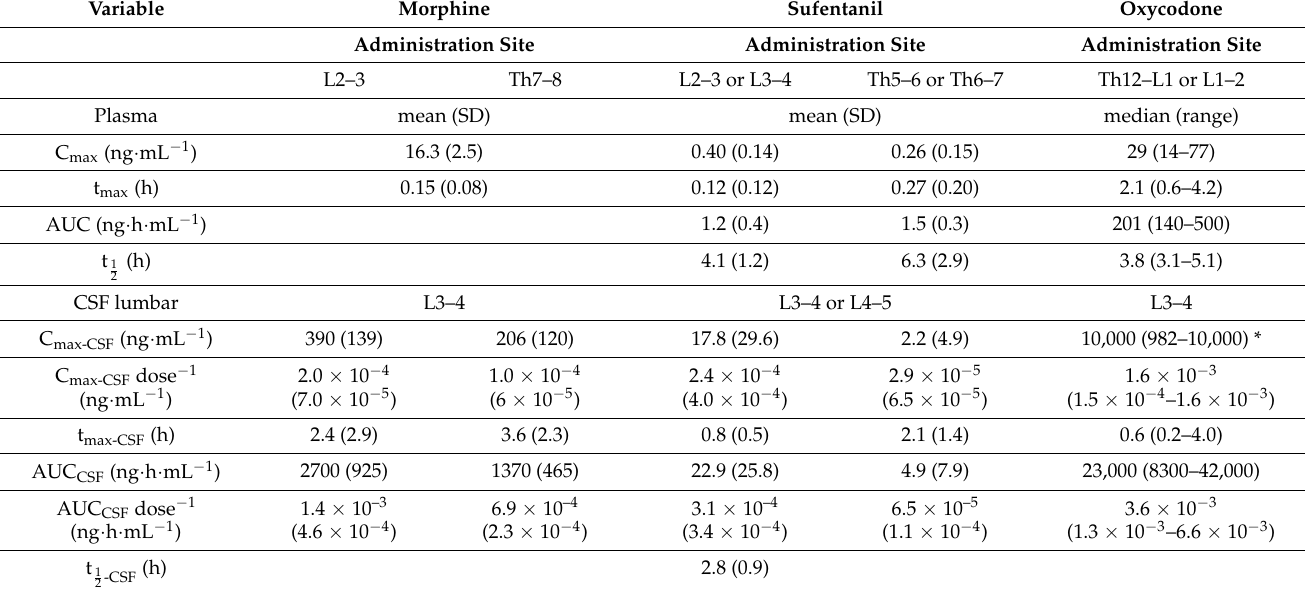
Table 3. Plasma and cerebrospinal fluid (CSF) and pharmacokinetics (PK) of epidural oxycodone and the commonly used hydrophilic opioid morphine and the lipophilic opioid sufentanil after lumbar and thoracic epidural administration. Oxycodone 0.1 mg kg − 1 , morphine 2 mg and sufentanil 75 µ g were diluted in 10 mL saline. Data are median (range) for oxycodone and mean (standard deviation) for morphine and sufentanil. Adapted from Kokki et al. (2014), Nordberg et al. (1987) and Hansdottir et al. (1995). AUC, area under the curve; AUC CSF area under the curve in CSF; C max , maximum concentration; C max-CSF , maximum concentration in CSF; t max , time to maximum concentration; t max-CSF , time to maximum concentration in CSF; t 1 , elimination half-life; t 1 , elimination half-life 2 2 -CSF in